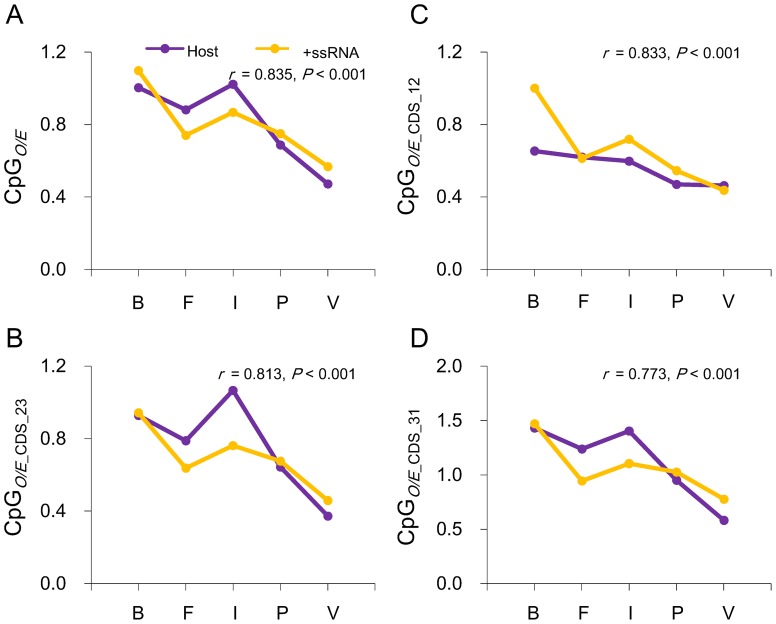
+ssRNA viruses mimic the CpG usage of their respective host.Correlation between +ssRNA viral and host's mean CpGO/E (A), mean CpGO/E
_CDS_12 (B), mean CpGO/E
_CDS_23 (C), and mean CpGO/E
_CDS_31 (D). The abbreviations at the bottom of each chart (B, F, I, P, and V) represent bacteria or bacterial-infecting +ssRNA viruses, fungi or fungus-infecting +ssRNA, invertebrates or invertebrate-infecting +ssRNA viruses, plants or plant-infecting +ssRNA viruses, and vertebrates or vertebrate-infecting +ssRNA viruses, respectively.